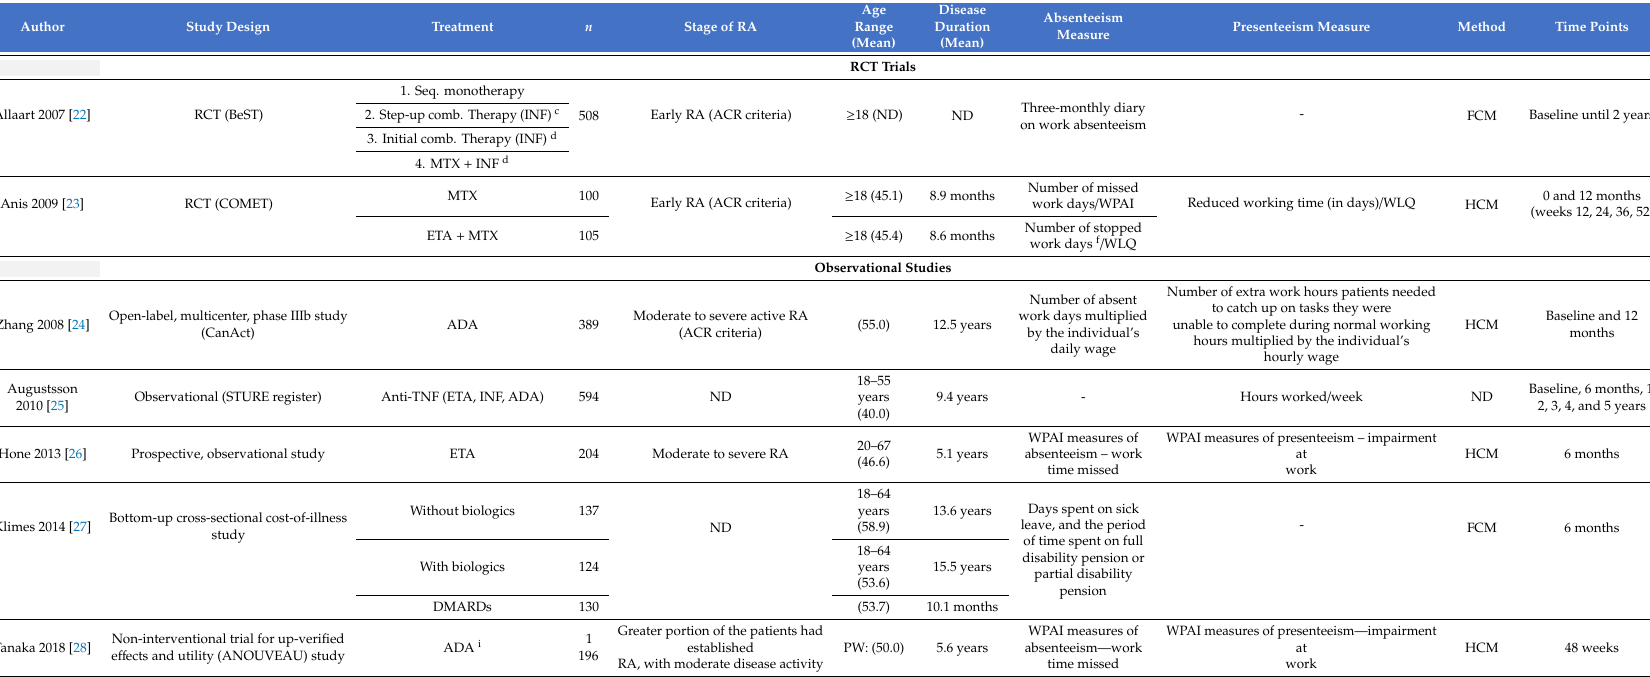
Table 1. Methodology of trials about the e ff ect of biological treatment on absenteeism and